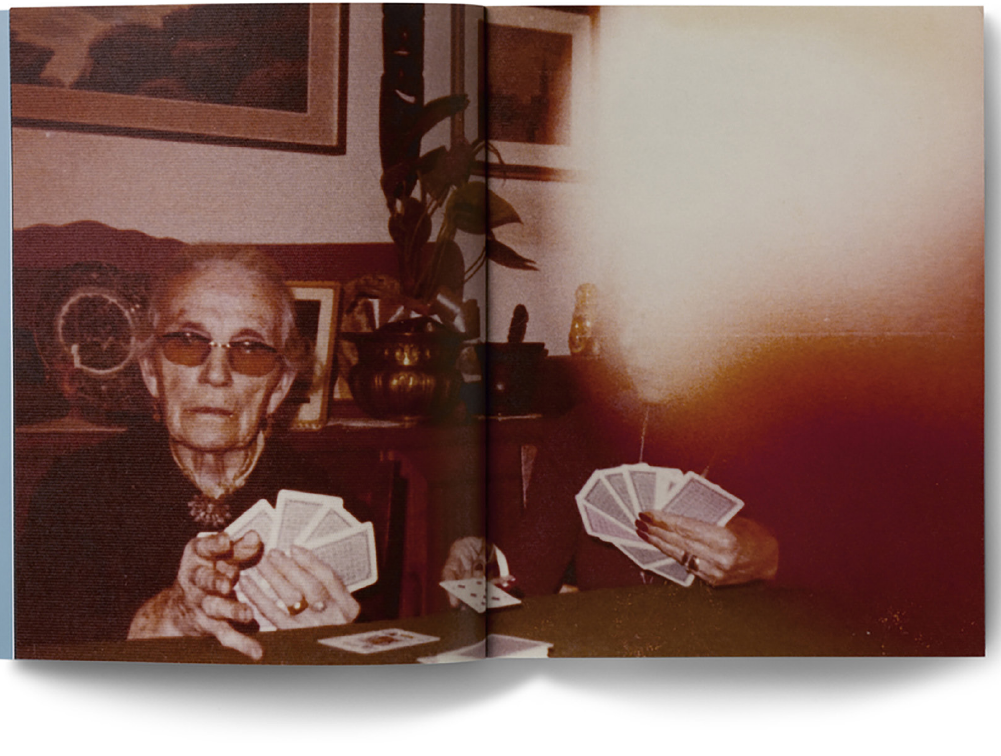
Fig. 4 Erik Kessels (2014). Courtesy of Erik Kessels © 2022. This is a book focused on the most common mistake in the history of image-making: the finger on the camera